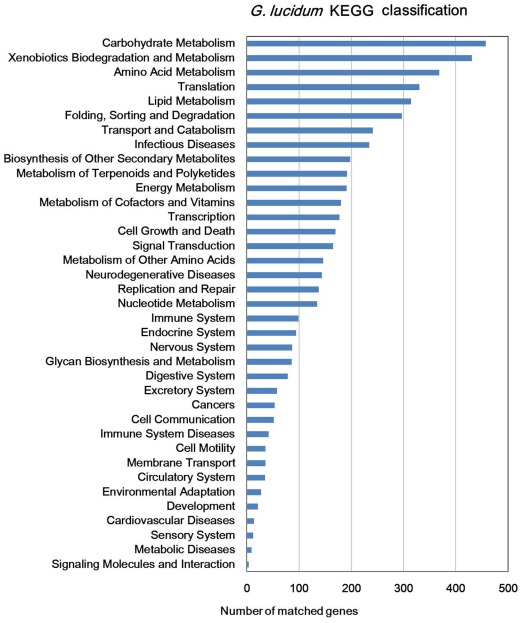
The KEGG function annotaion of G. lucidum.Distribution of Genes in different KEGG categories.